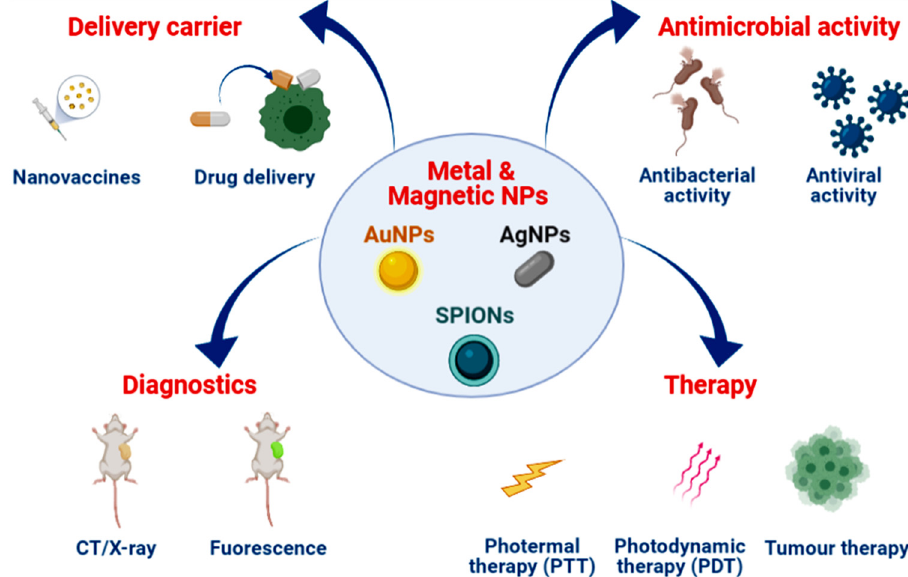
Figure 4: Metal and magnetic nanoparticles ( MNPs and MgNPs ) including AuNPs, AgNPs, and SPIONs. They present a natural antimicrobial activity ( antibacterial and antiviral ) ; can act as delivery carriers both in drug delivery and nanovaccines; can be employed in diagnostics ( CT/X - ray and fl uorescence analysis ) and in disease therapy ( e.g. , tumour therapy, photothermal, and photodynamic therapy )